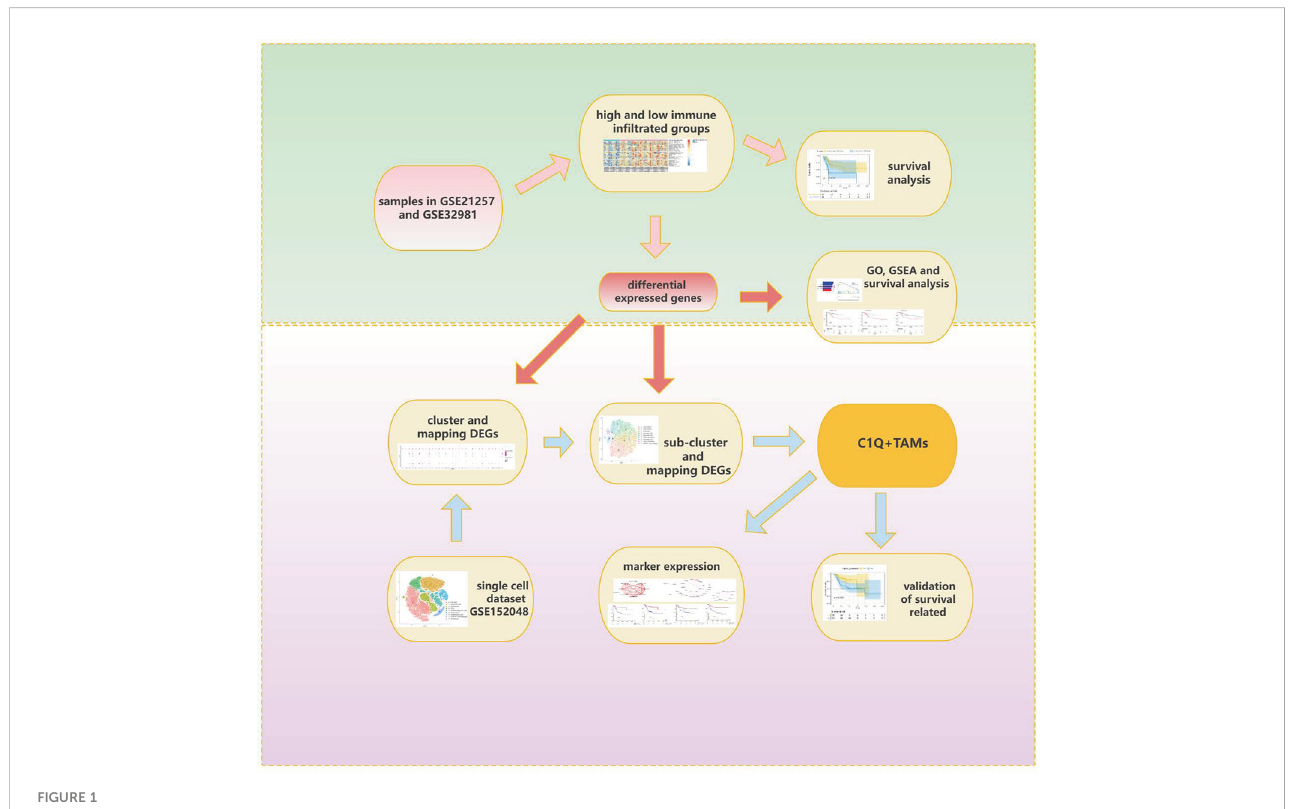
FIGURE 1 Work fl ow of this